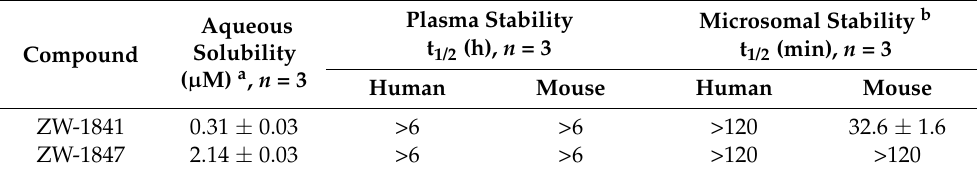
Table 2. Solubility and in vitro metabolic stabilities of selected compounds. Compound